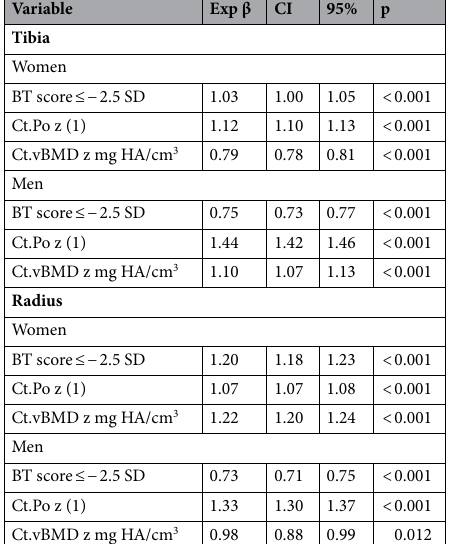
Variable Exp β CI 95% p Tibia